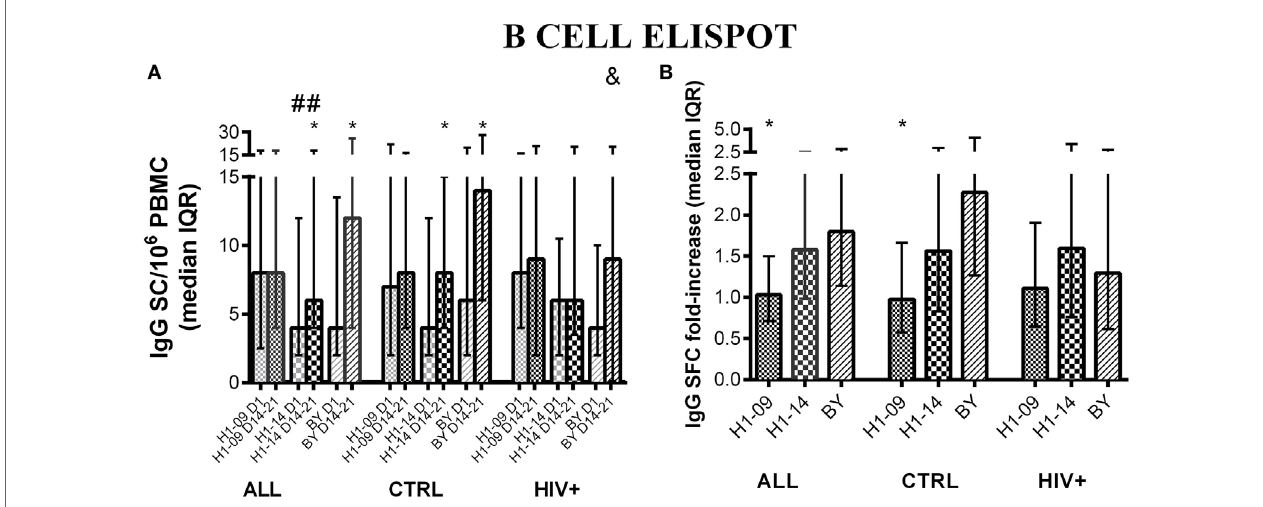
FigUre 2 | igg memory B-cell responses to laiV4 measured by elisPOT . The data were derived from 45 HIV-infected and 55 uninfected individuals. (a) Absolute responses in each group of participants, as indicated below the abscissa, at V1 (before vaccination) and V4 (14–21 days after vaccination) and against the viruses indicated in the labels of the abscissa. Asterisks (*) indicate significant differences between pre- and post-vaccination. Hash tags (#) indicate significant differences between H1N1-09 and H1N1-14. And symbols (&) indicate significant differences between HIV-infected and uninfected participants. (B) Fold-increases from pre- to post-vaccination. Asterisks (*) indicated significant differences between H1N1-09 and